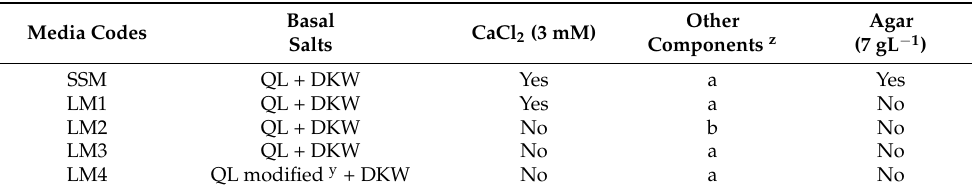
Figure 1. Temporal Immersion System (SIT) in Plantform TM bioreactors. Initial stage of ‘Canino’ shoots ( A , B ), and proliferation after four weeks ( C , D ). Table 1. Culture media used for apricot micropropagation and modifications to study AgNPs incorporation in plant tissues.